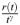
Displacement probability distributions collapse at similar scaling exponents.Displacement probability distribution P(ρ), where ρ(t) is the scaled displacement r(t)tγ, for the value of γ that best collapses the data, for (A) Mouse fibroblast cells, (B) generalized SPP model and (C) Lévy walk, with colors representing 4 binned timescales from blue (small) to yellow (large) at times t = 5, 10, 15 and 20 hours. Mouse fibroblast P˜(ρ) is shown as a dashed red line in (B, C) for comparison with each model, showing that only the generalized SPP model is consistent with the observed data. Collapsed mouse fibroblast distributions are fit to a Gaussian (A) shown as a dashed black line, artificially shifted for visibility. See Fig 4 for a characterization of different γ values for each model, characterized by χ2.